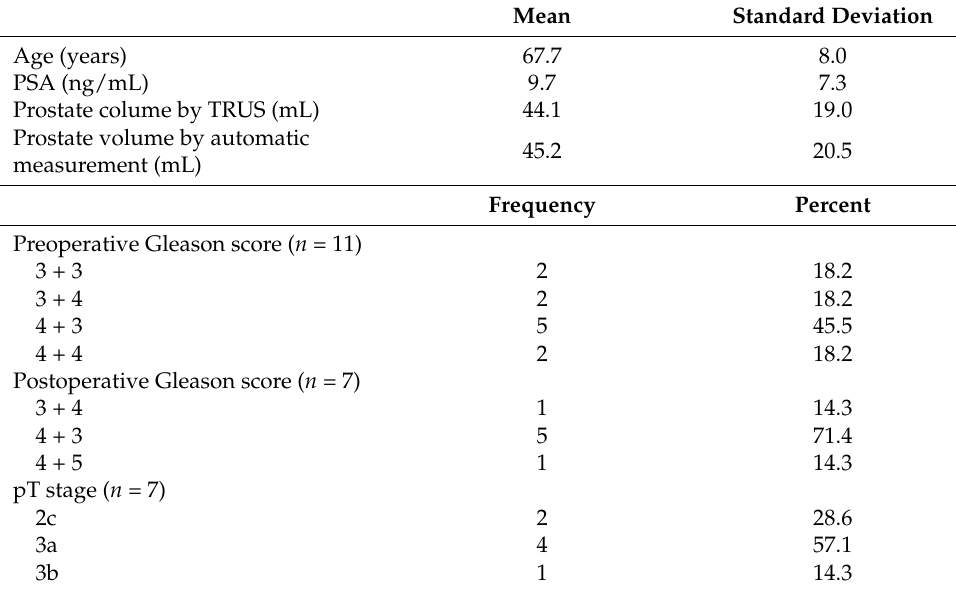
Table 1. Descriptive patients’ characteristics in the